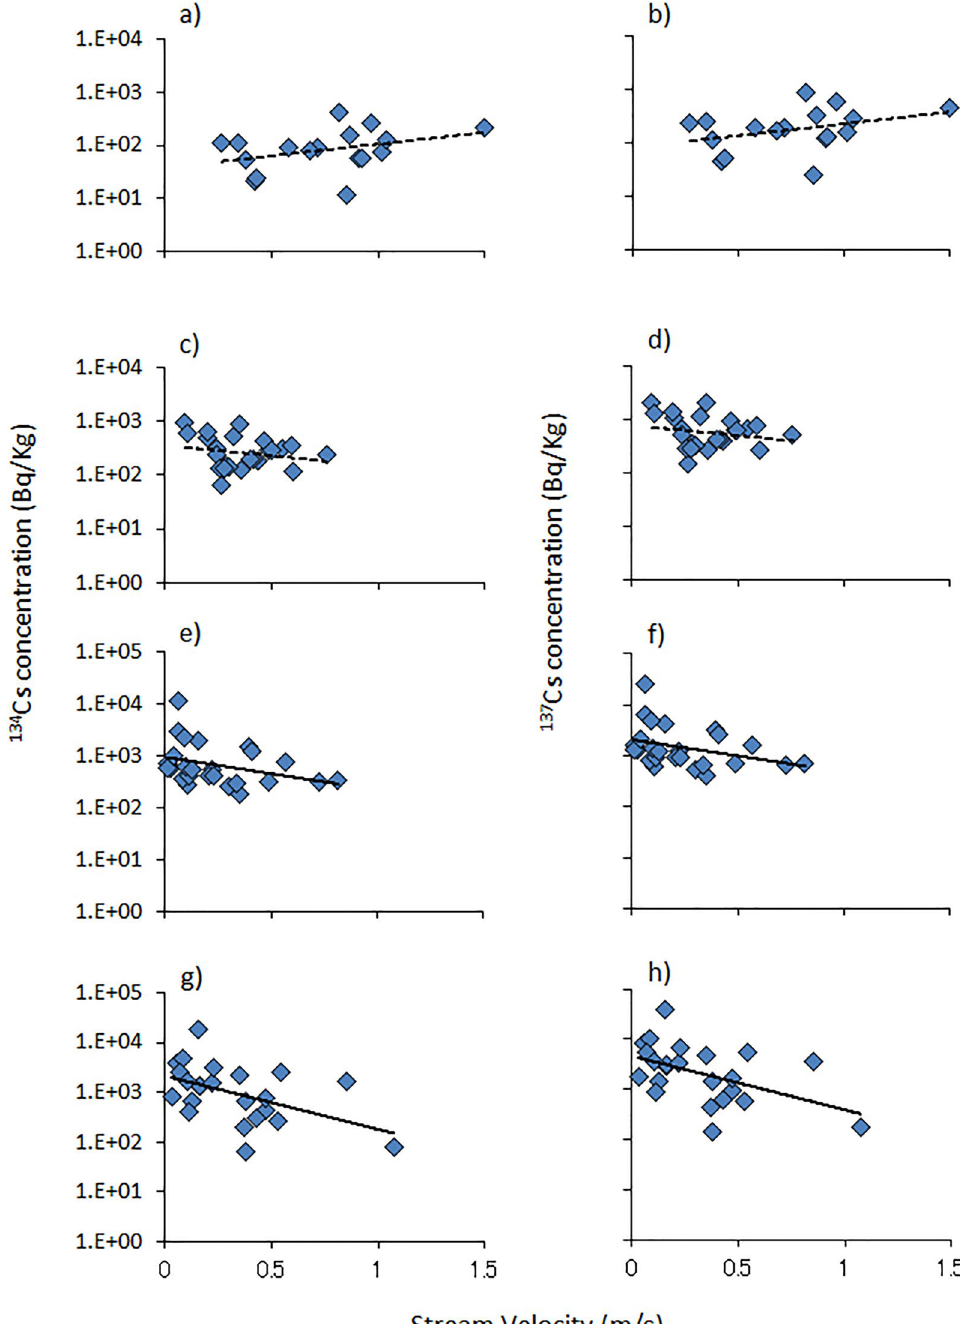
cesium-137; c) site B, cesium-134; d) site B, cesium-137; e) site C, cesium-134; f) site C, cesium-137; g) site D, cesium-134; h) site D,